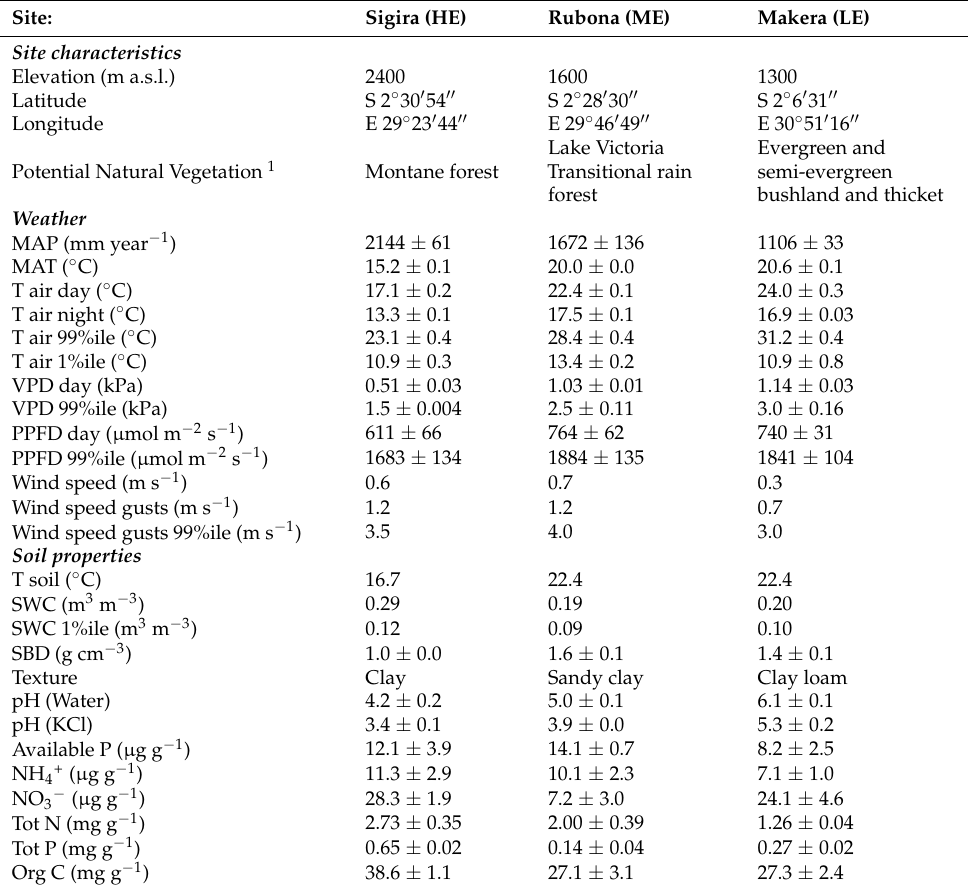
Table 1. Site, weather and soil characteristics at Rwanda TREE experimental sites. Weather data are annual mean ± SD for the period 1 February 2018–31 January 2020, except for wind, which is given for 1 February 2019–31 January 2020. Soil data are mean ± SD of three blocks (1 block = 6 subplots). HE, high elevation; ME, mid elevation; LE, low elevation; MAT, mean annual temperature; MAP, mean annual precipitation; T air day and night, mean air temperature in light and darkness (< and >2 µ mol m − 2 s − 1 PPFD), respectively; VPD day, daytime mean vapour pressure deficit; PPFD day, daytime mean photosynthetic photon flux density; gust wind speed, average of maximum half-hourly wind speeds; T soil, mean soil temperature at 10–20 cm depth; SWC, soil water content at 10–20 cm depth; SBD, soil bulk density; P, phosphorus, N, nitrogen; Org C, organic carbon; All soil parameters from SBD and downwards are average between 0–30 cm depth. Site: Sigira (HE) Site characteristics Elevation (m a.s.l.)